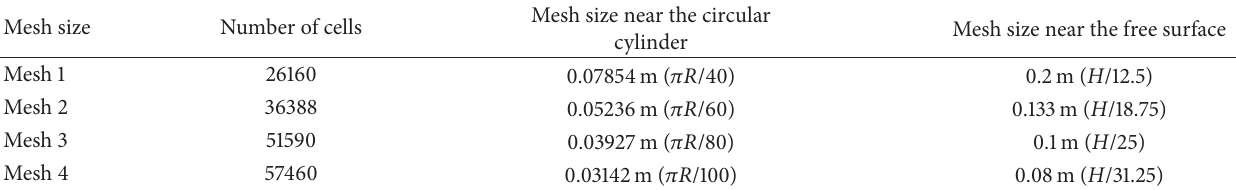
Figure 3: Wave elevation at four different locations: (a) 𝑥 = 50 m; (b) 𝑥 = 100 m; (c) 𝑥 = 200 m; (d) 𝑥 = 300 m. Table 1: Mesh sizes used for mesh size